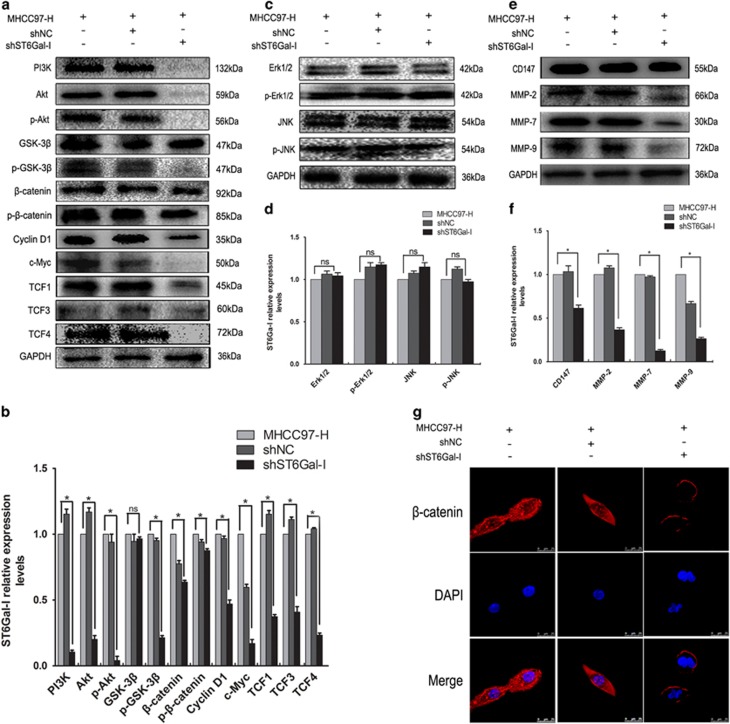
Knockdown of ST6Gal-I inhibits PI3K/Akt, and Wnt/β-catenin signaling pathways in MHCC97-H cells. (a, c, e) Main protein components of the PI3K/Akt/MAPK/β-catenin signaling pathway in MHCC97-H cells were measured using western blotting. (b, d, f) Relative protein intensities were determined using Image Lab software. Error bars represent s.d. *P<0.05. (g) Subcellular localization of β-catenin in MHCC97-H cells treated with shST6Gal-I plasmids, examined by confocal microscopy. Cells with typical morphology are presented.